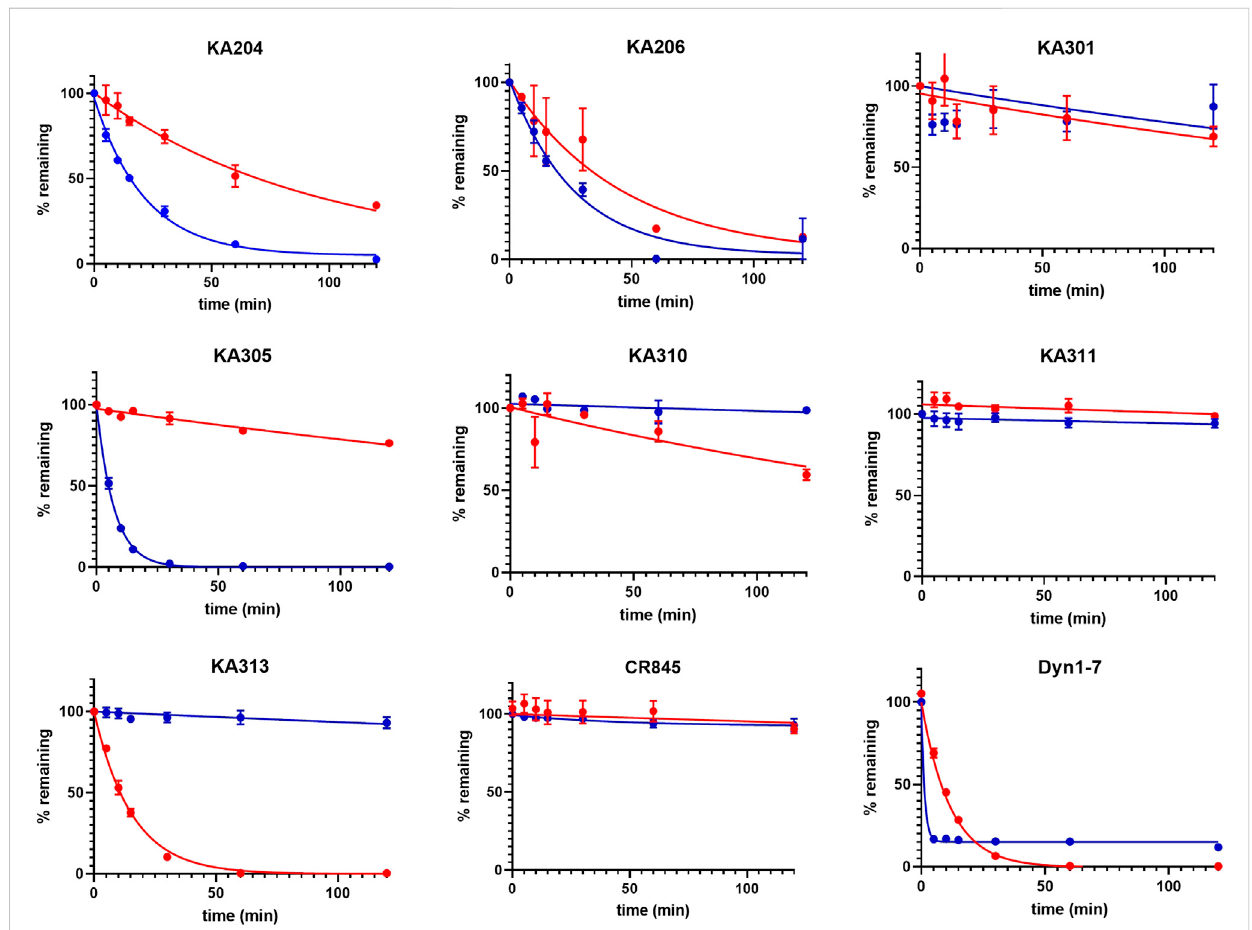
FIGURE 2 Metabolic stability of the most promising selected peptides in trypsin (blue) and rat plasma (red). The half-lives determined from these data are presented in Table 1 (means ± SEM; n = 3 in duplicate per data point).